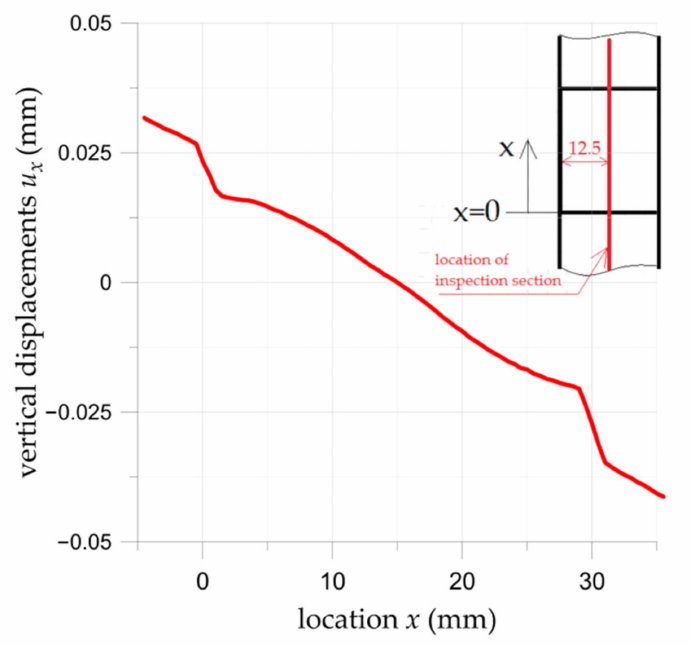
Figure 13. Distribution of surface vertical displacements u x (DIC) in middle section of double-lap adhesively joint with S&P C-Laminate 150/2000